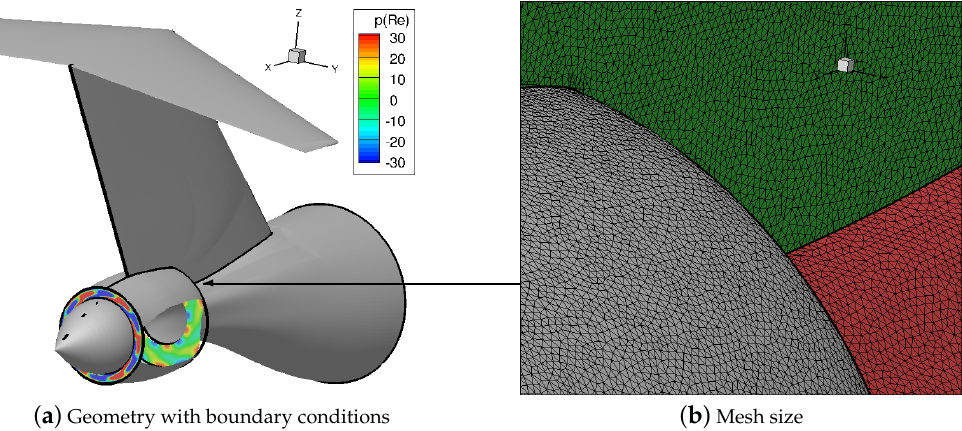
Figure 11. Aircraft portion geometry used in aeroacoustic simulation, with particular of the compu- tational mesh